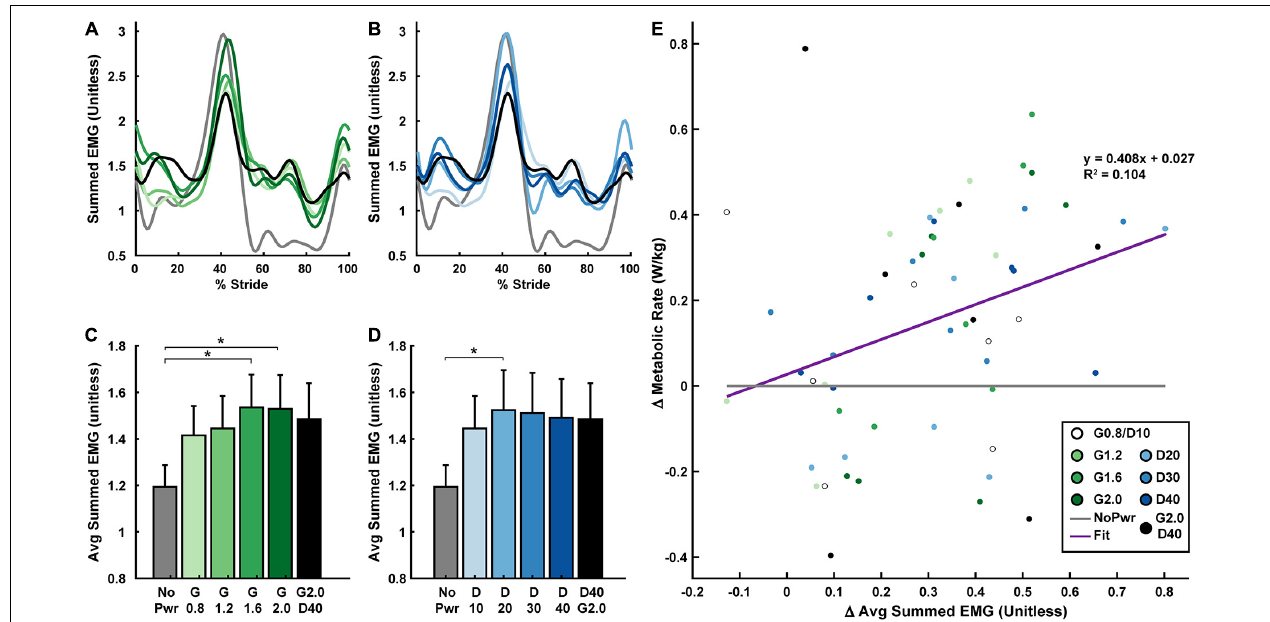
FIGURE 7 | User’s summed ankle muscle activity versus metabolic rate. Measurements of users’ summed normalized electromyography (EMG) signals recorded from soleus + medial gastrocnemius + lateral gastrocnemius + tibialis anterior (SOL+MG+LG+TA) over a stride from heel strike (0%) to heel strike (100%) of the same leg are shown (A,B) . Bar graphs are averages of the summed EMG signals over the stride (C,D) . All measurements are averages across the study participants ( N = 9) in each condition with varying neuromuscular model (NMM) controller reflex Gain (green) in left panel (A,C) and Delay (blue) in the right panel (B,D) . Linear regression between the change in metabolic rate versus the change in average summed EMG with respect to the unpowered (NoPwr) condition (E) . * denotes pairwise significant difference of p < 0.05. R 2 value is denoted with a “ ∼ ” if the linear regression was not statistically significant. Conditions are abbreviated and color coded as follows: unpowered (NoPwr) (gray), NMM reflex Gains of 0.8, 1.2, 1.6, and 2.0 all with reflex Delay = 10 ms (G0.8, G1.2, G1.6, and G2.0, respectively) (green), NMM reflex Delays of 10, 20, 30, and 40 ms all with a reflex Gain = 1.2 (D10, D20, D30, D40, respectively) (blue), and a high-Gain-high-Delay condition (G2.0 D40)